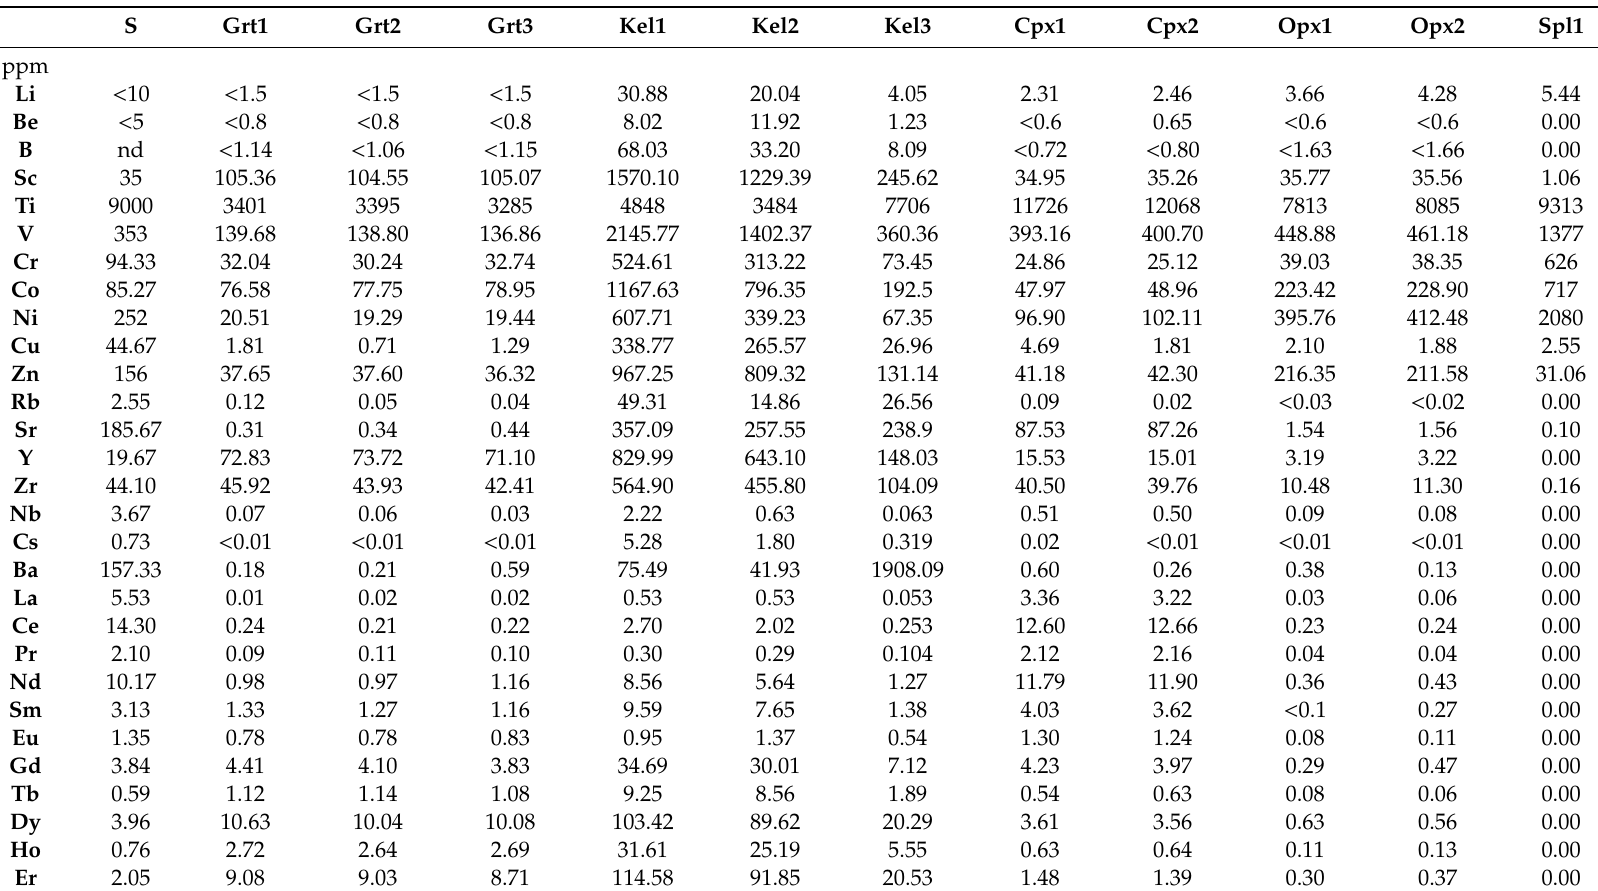
Table 2. Trace element abundances of the sample whole rock (S), garnet (Grt), kelyphite (K), clinopyroxene (Cpx) and Ca-poor pyroxene (Opx). The whole rock is the average composition of three di ff erent fragments of the sample. Analyses of minerals and kelyphite are representative Laser-Ablation spots. nd = not